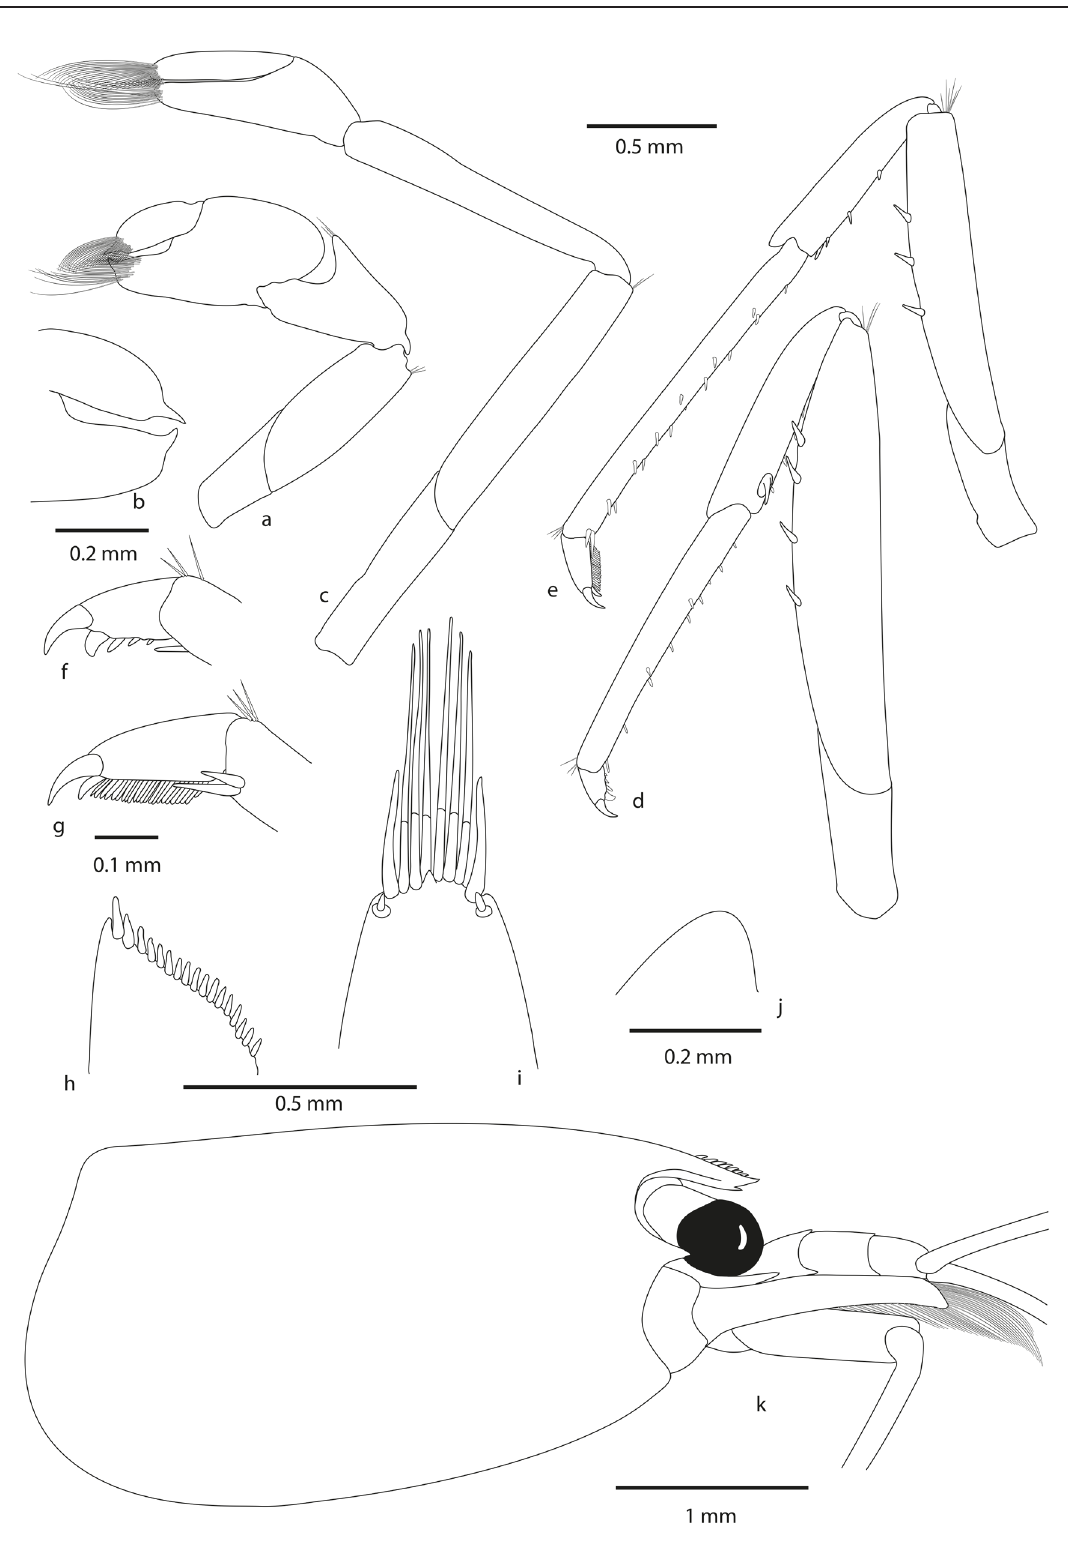
Fig. 19. Caridina nana sp. nov. a . First pereiopod. b . Details of the fingers of the first pereiopod. c . Second pereiopod. d . Third pereiopod. e . Fifth pereiopod. f . Dactylus of third pereiopod. g .